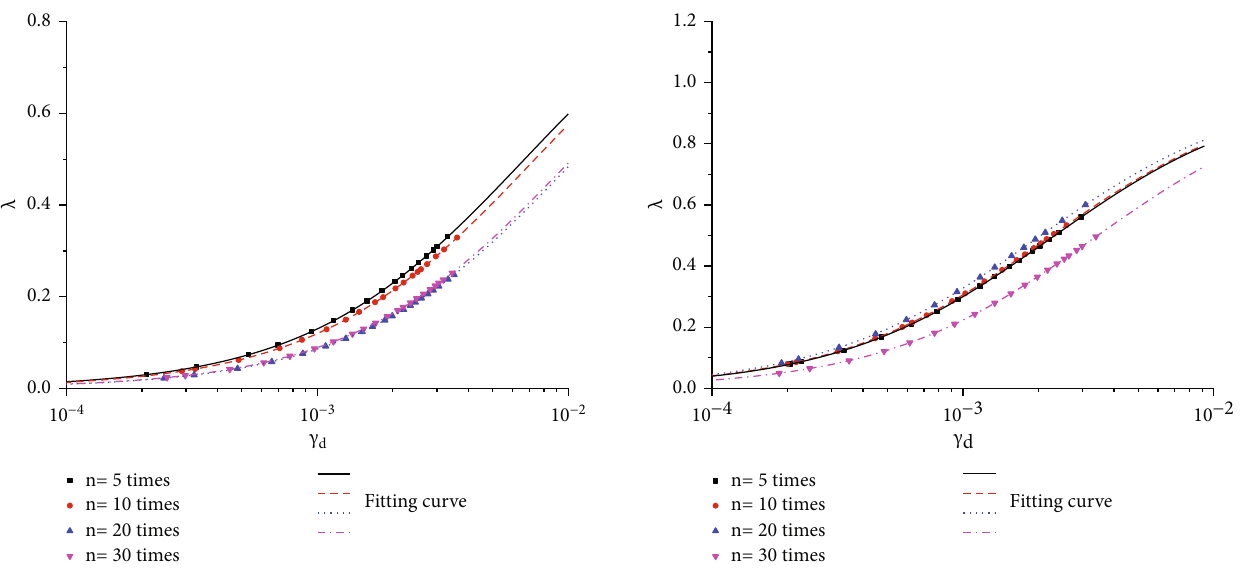
Figure 18: Damping ratio-strain curves under di ff erent freeze-thaw cycles (-15 °